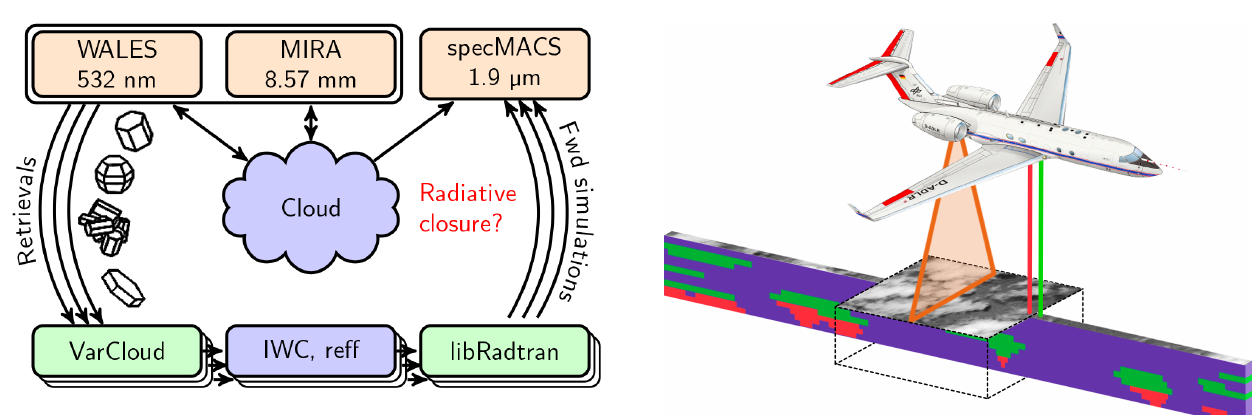
Figure 1. Overall strategy to validate the lidar–radar (WALES/MIRA) retrieval results (VarCloud) for different as- sumptions about the ice crystal shape by radiative closure between measured (specMACS) and simulated (libRadtran) solar radiances.